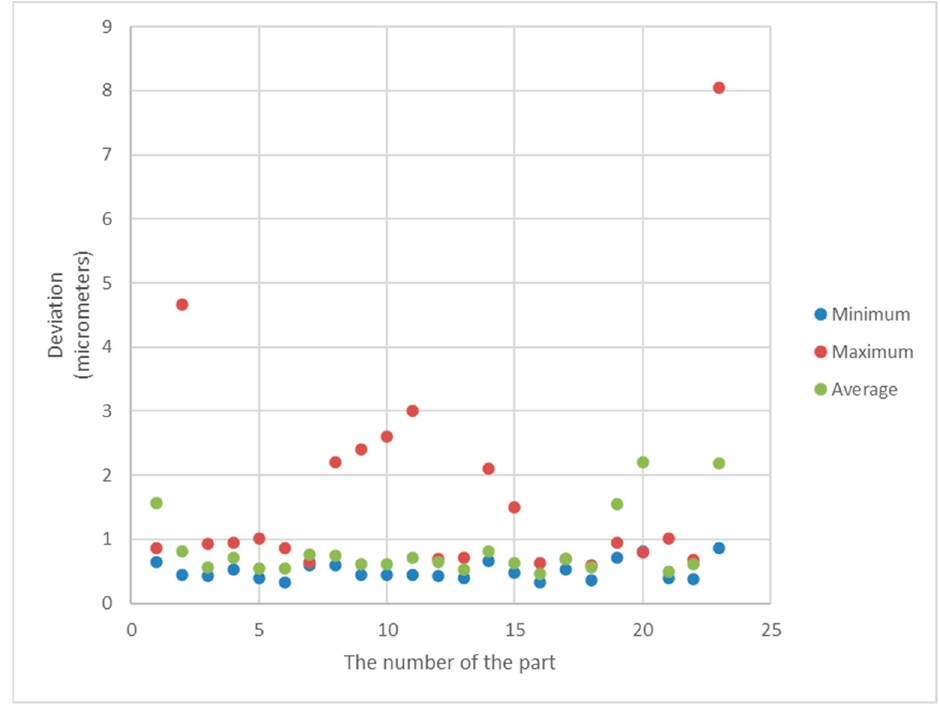
Figure 12. Minimum, maximum and average values of the form deviation for each sphere from the second dataset.